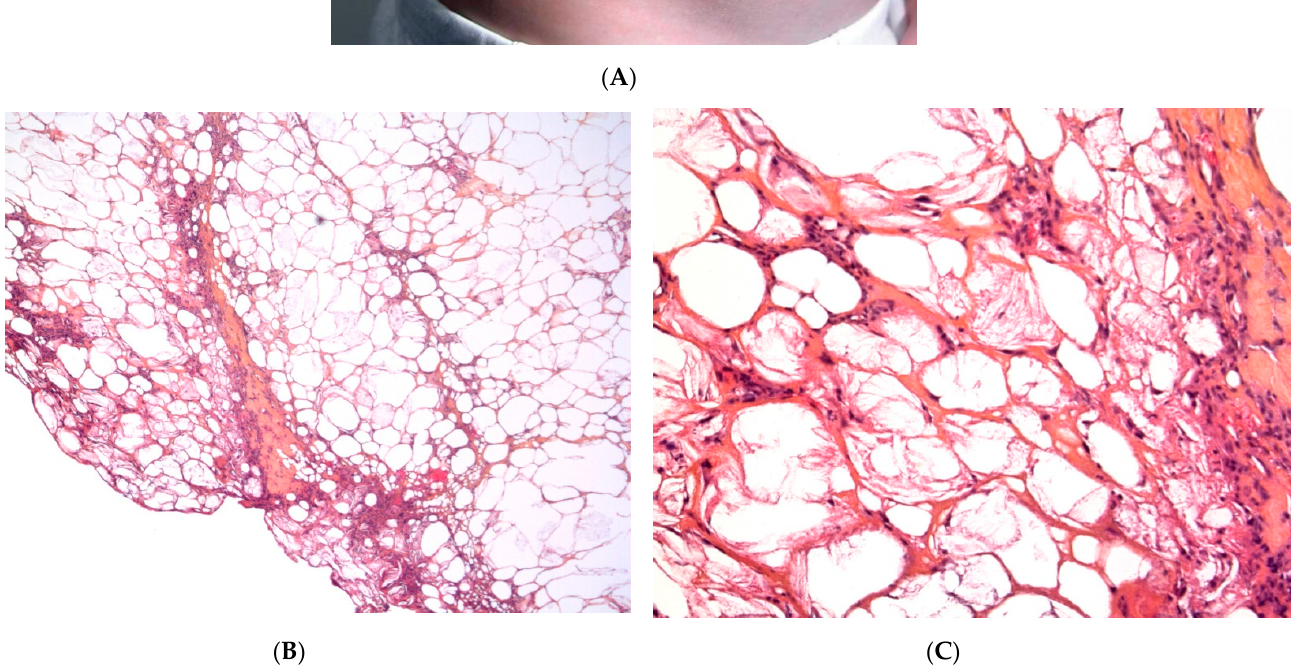
Figure 2. Post-steroid panniculitis. ( A ) Clinical presentation: subcutaneous nodules with overlying erythema. ( B ) Histopathologic features of post-steroid panniculitis: mostly lobular panniculitis with an inflammatory infiltrate of foamy histiocytes involving the fat lobules (original magnification ×40). ( C ) Needle-shaped clefts (original magnification ×400).